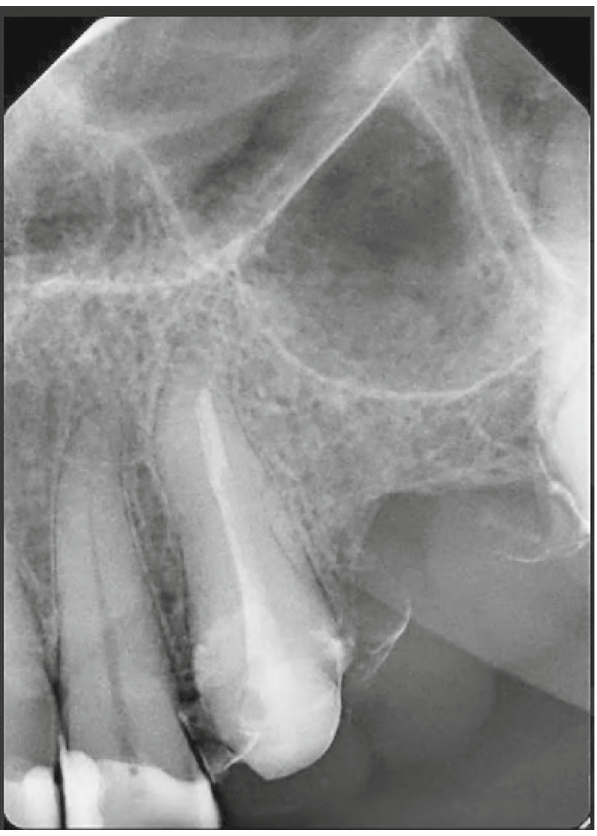
Figure 1: Preoperative radiographic assessment showing tooth #23 with permanent core retained with a fi ber post and inadequate root canal fi